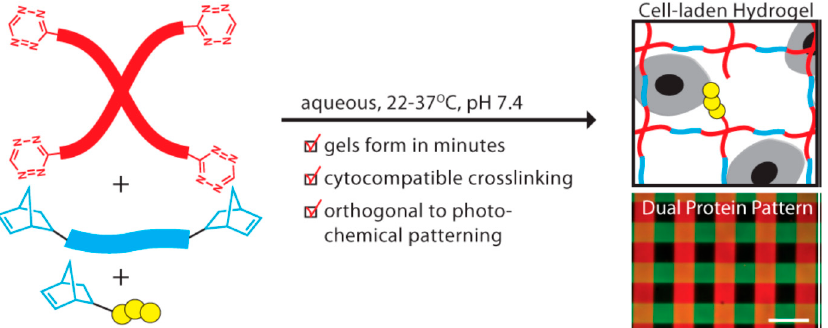
Figure 3. Synthetically tractable click hydrogels for three-dimensional cell culture formed using tetrazine–norbornene chemistry. Reprinted from [71] with permission from the American Chemical Society (2013).